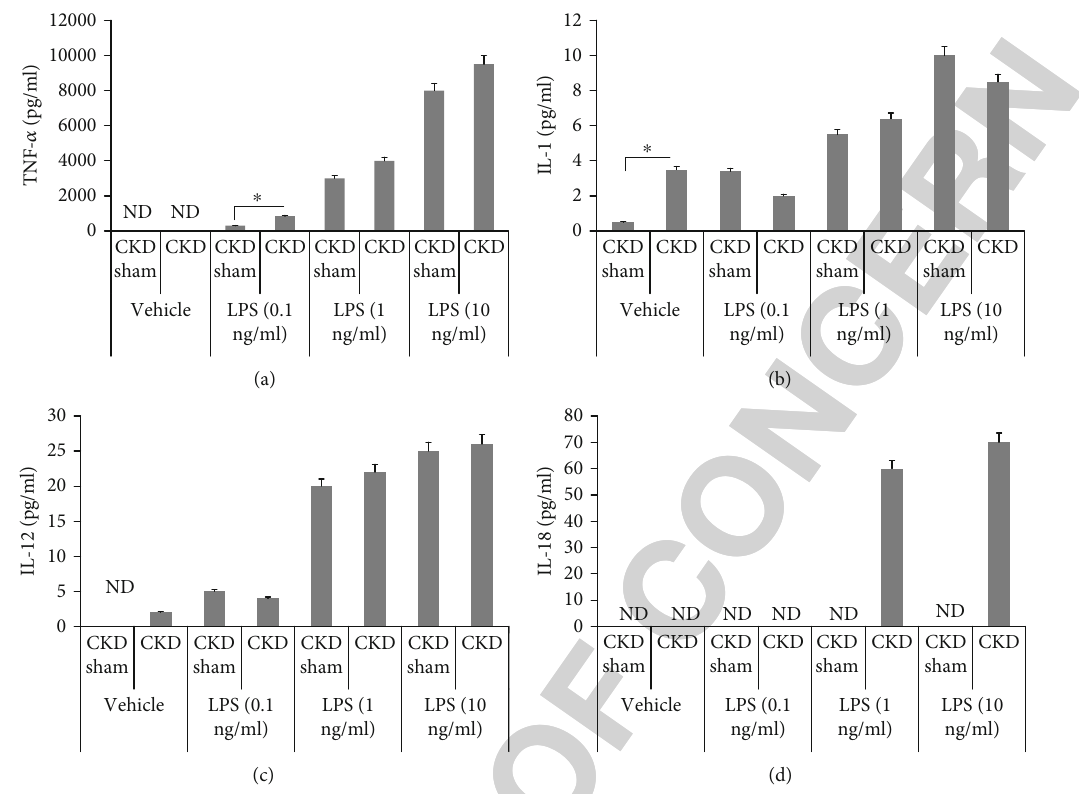
Figure 6: Levels of cytokines in supernatants of macrophages derived from CKD, sham, and CKD chronic mice after treating with LPS: (a) levels of tumor necrosis factor- (TNF-) α (pg/mL) in the supernatant of macrophages; (b) levels of interlukin-1 in the supernatant (pg/mL); (c) levels of interlukin-12 in the supernatant (pg/mL); (d) levels of interlukin-18 in the supernatant (pg/mL). All results are presented as mean ± SEM . ND: not detected. ∗ P < 0 : 05 compared to macrophages derived from CKD sham-operated